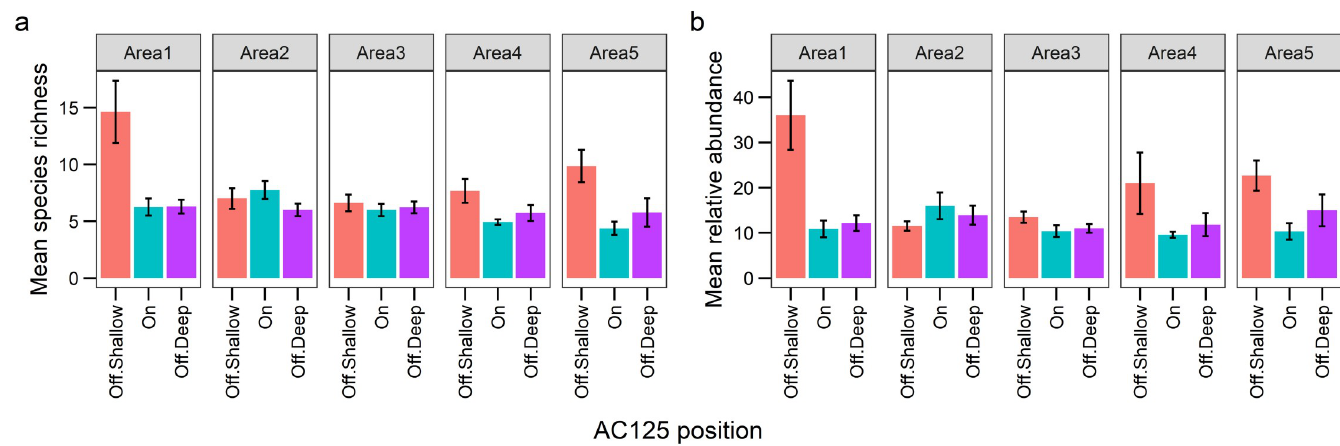
Fig 3. Mean ( ± SE) fish species richness (a) and relative abundance (MaxN, b) per BRUVS deployment observed on and off the AC125 in five sampling areas.